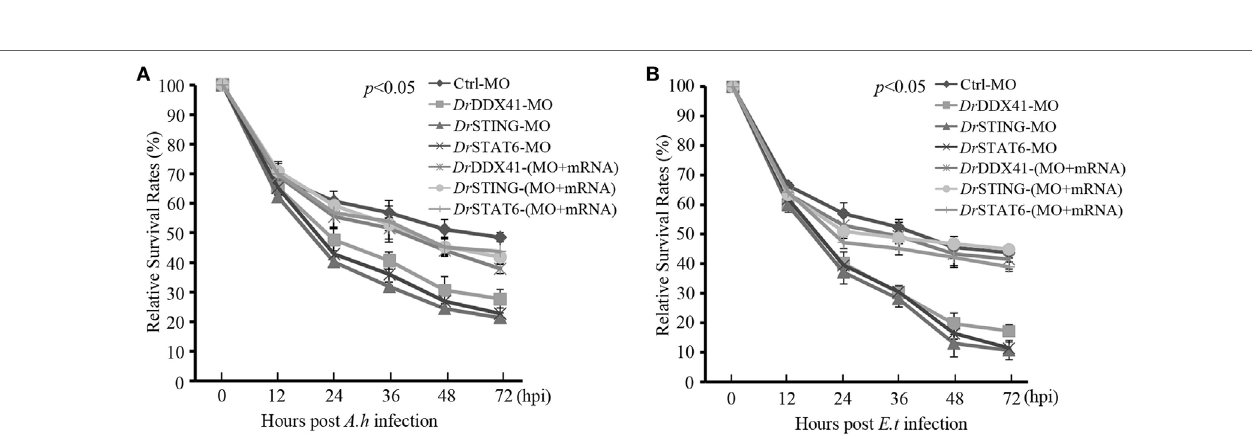
FigUre 9 | Function of different Danio rerio DDX41 ( Dr DDX41) domains in the signaling pathways. (a) Schematic diagram of full-length and mutated Dr DDX41 fragments, which were inserted into the C-terminus of pCMV-Tag2B. (B,c) Dr DDX41 (B) and its mutants [ (c) , constructed as in panel (a) ] interact with Danio rerio STING ( Dr STING). HEK293T cells were transfected with Flag- Dr DDX41/its mutants and Myc- Dr STING for 24 h. Cell lysates were immunoprecipitated with anti-Myc antibody (Myc) and analyzed by western blot using anti-Flag and anti-Myc antibodies. Expression of the transfected plasmids was analyzed with anti-Flag and anti-Myc antibodies in the whole cell lysates. (D–F) Activation of the nuclear factor- κ B (NF- κ B)-binding (D) , Hs IRF3 (e) , or Hs IFN β (F) promoters in HEK293T cells transfected with an NF- κ B/ Hs IRF3/ Hs IFN β -Luc reporter (150 ng/mL) and a renilla luciferase reporter (15 ng/mL) plus different vectors of Dr DDX41 (400 ng/mL) together with pCMV-N-Myc- Dr STING (200 ng/mL) and stimulated with poly(dA:dT) (1 µg/mL) for 6 h. Data are the average luciferase activity ± SD (* p < 0.05; ** p < 0.01). (g) Quantitative RT-PCR analysis of Hs CCL20 mRNA levels in HEK293T cells transfected with different constructions of Dr DDX41 (400 ng/mL) plus pCMV-N-Myc- Dr STING (200 ng/mL) and stimulated with poly(dA:dT) (1 µg/mL) for 6 h. Data are representative of three